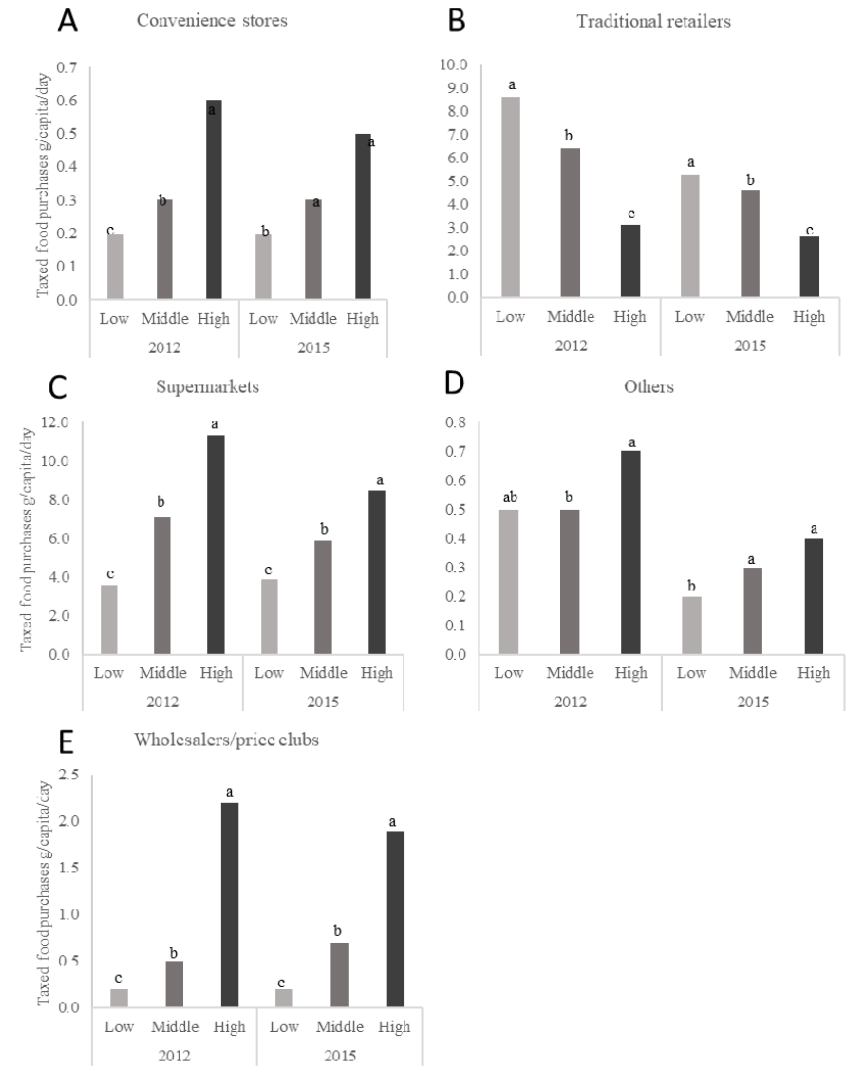
Figure 3. Daily per capita purchases of taxed foods in urban Mexican households, according to SES, for the years 2012 and 2015. n = 959 in the low-SES, n = 3133 in the medium-SES, and n = 1721 in the high-SES group in 2012 and n = 1170 in the low-SES, n = 2690 in the medium-SES, and n = 1633 in the high-SES group in 2015. Subgraphs refer to taxed food purchases by store-type including ( A ) convenience stores, ( B ) traditional retailers, ( C ) supermarkets, ( D ) home water-delivery, and ( E ) wholesalers and price clubs. Values represent weighted unadjusted means. SES classification is based on the socioeconomic index provided by Nielsen. Multivariate linear regression models were used to predict per capita daily purchases of taxed foods according to store-type, SES, and year of purchases. Data presented are restricted to the Nielsen CPS purchasing information for 2012 and 2015 only for clarity. However, p -values represent the p -trend for years 2012, 2013, 2014, and 2015. Labeled means with a different letter represent significant differences between the SES categories means ( p -trend < 0.05) where the letters a,b,c are used to differentiate the highest, middle, and lowest mean values for each figure in the panel. Source: Authors’ own analyses and calculations based on data from Nielsen through its Mexico Consumer Panel Service (CPS) for the food and beverage categories for January 2012 to December 2015. The Nielsen Company, 2016. Nielsen is not responsible for and had no role in preparing the results reported in this